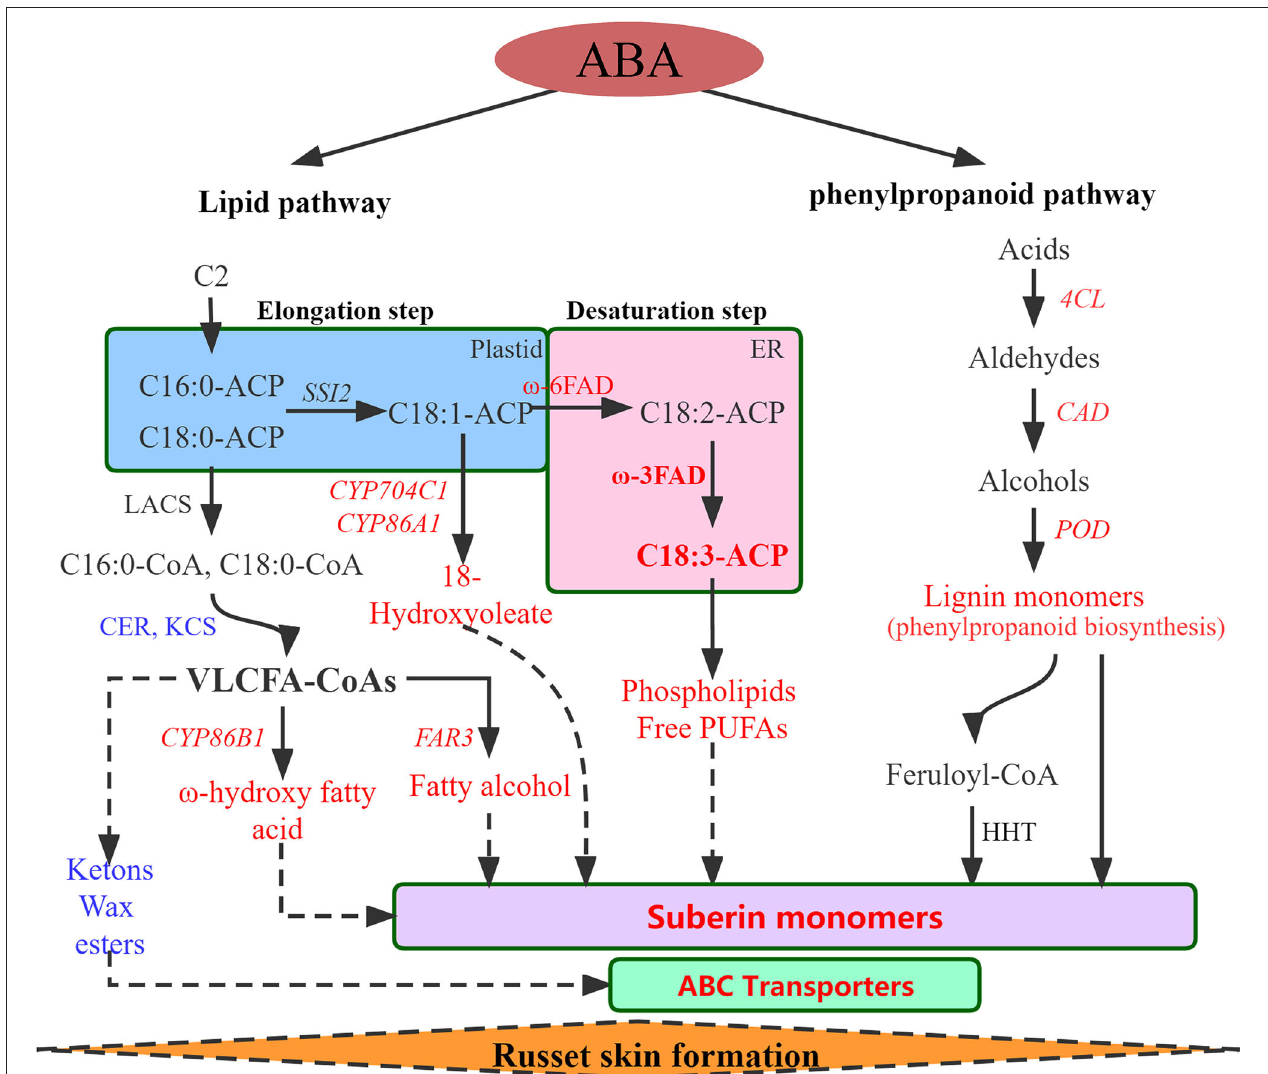
FIGURE 4 | Regulatory network of the biological pathways promoted by ABA in russet fruit skin formation based on RNA-Seq and metabolomics analysis. Red represents up-regulated and blue represents down-regulated. LACS, Long-chain acyl-CoA synthetase; CER, eceriferum; KCS, 3-ketoacyl-CoA synthase; CYP86A1, cytochrome P450 86A1; CYP86B1, cytochrome P450 86B1; CYP704C1, cytochrome P450 704C1; FAR3, Fatty acyl-CoA reductase 3; FAD, fatty acid desaturase; PUFAs, polyunsaturated fatty acid; 4CL, 4-coumarate–CoA ligase; CAD, cinnamyl alcohol dehydrogenase; POD, peroxidase; HHT. omega-hydroxypalmitate O-feruloyl transferase-like